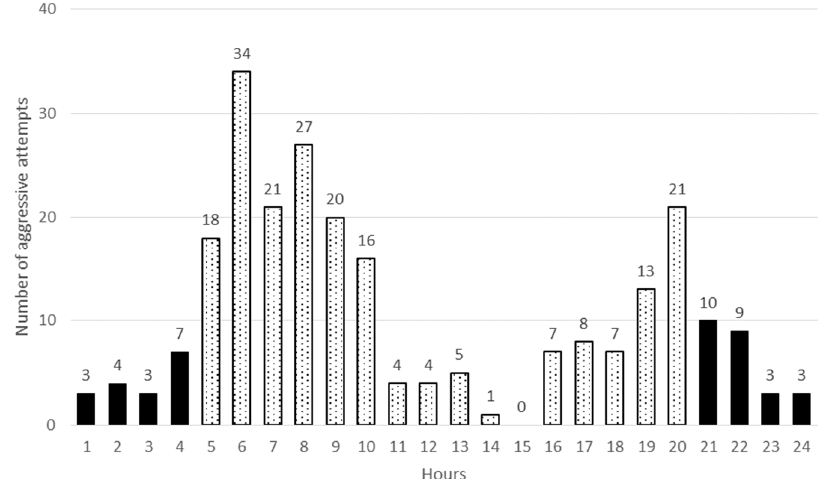
Figure 4. Number of aggressive interactions in relation to time of day in HET groups (light and dark columns show the light and dark periods of day).